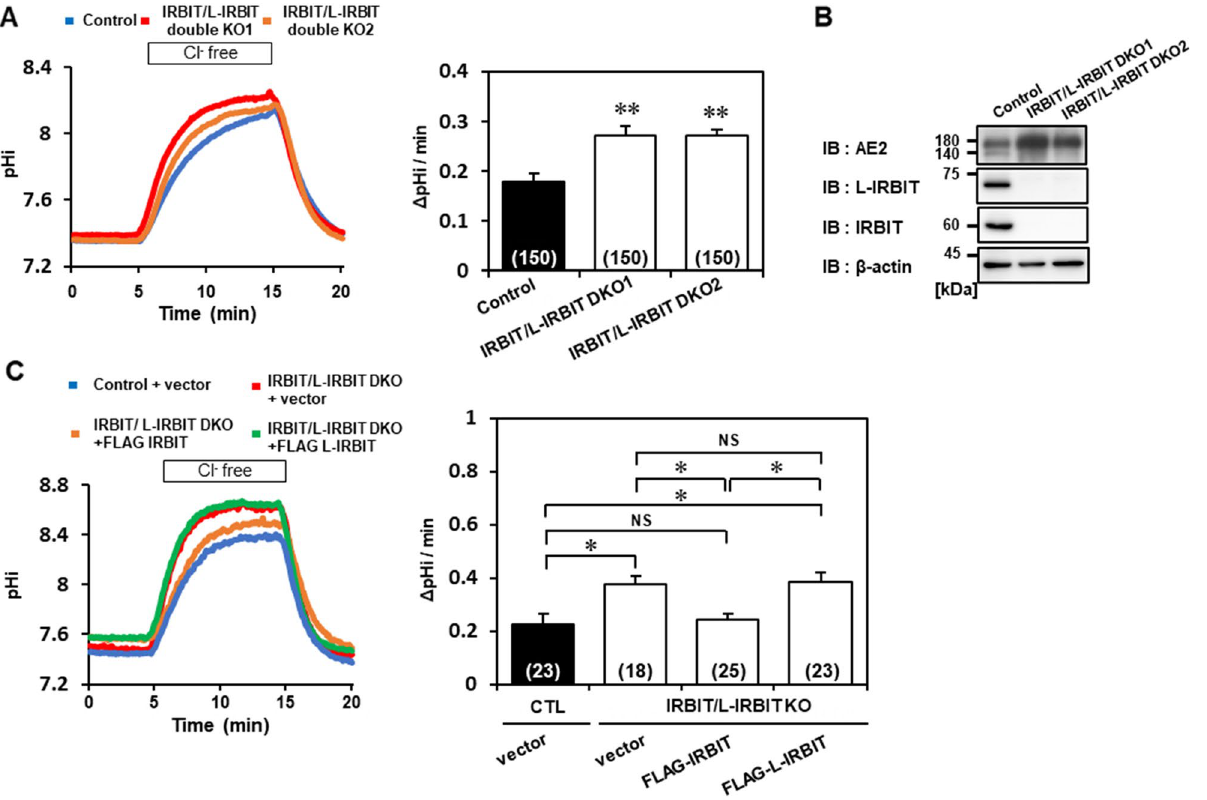
Figure 6. IRBIT homomultimer decreases the stability and activity of AE2. ( A ) IRBIT/L-IRBIT double KO cells were established using CRISPR/Cas9 strategy, and AE2 activity was measured in the cells. A representative plot of pHi change obtained from control (blue), IRBIT/L-IRBIT DKO clone 1 (red), and IRBIT/L-IRBIT DKO clone 2 (orange) (left panel). The average AE2 activity (ΔpH/min) was 0.17 ± 0.01 (WT), 0.26 ± 0.02 (IRBIT/L-IRBIT DKO1), and 0.24 ± 0.01 (IRBIT/L-IRBIT DKO2), N = 5 (right panel). ( B ) Protein expression of IRBIT, L-IRBIT, and AE2 in IRBIT/L-IRBIT double DKO cells was verified using immunoblotting. ( C ) The effects of the exogenous expression of IRBIT or L-IRBIT on AE2 activity in IRBIT/L-IRBIT DKO cells were analyzed. IRBIT or L-IRBIT expressing cells were selected based on the GFP co-expressed signals. Blue trace is the control cells, a red trace is the IRBIT/L-IRBIT DKO cells, an orange trace is IRBIT/L-IRBIT DKO cells expressed with IRBIT, and a green trace is IRBIT/L-IRBIT DKO cells expressed with L-IRBIT (left panel). Average AE2 activity in each cell type was 0.22 ± 0.04 (WT + vector), 0.37 ± 0.03 (IRBIT/L-IRBIT DKO + vector), 0.24 ± 0.02 (IRBIT/L-IRBIT DKO + IRBIT), 0.35 ± 0.02 (IRBIT/L-IRBIT DKO + L-IRBIT), N = 4—5 (right panel). The total cell numbers were indicated in each graph. ** P < 0.01, NS (no